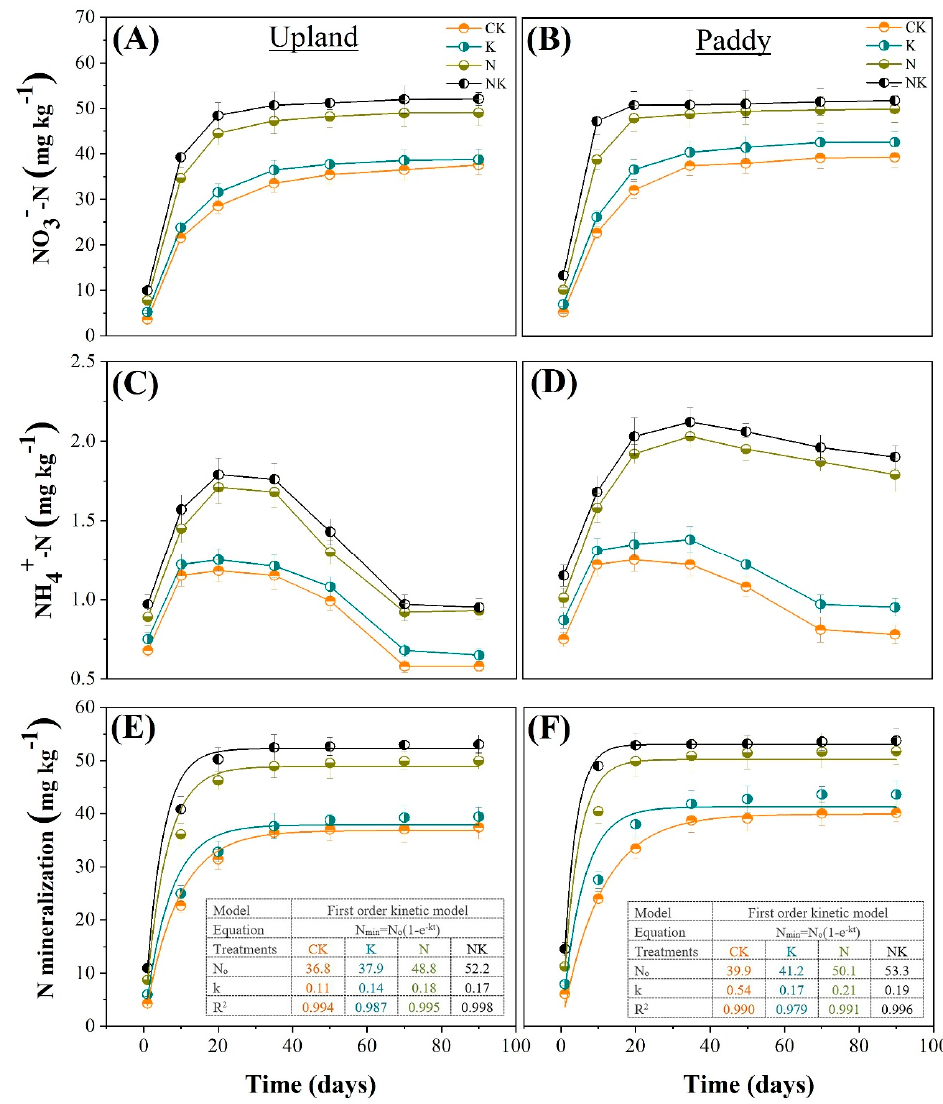
Figure 3. The concentrations of NO 3 − -N, NH 4+ -N and net N mineralization in different fertilization management practices after 90 days of incubation in upland ( A , C , E ) and paddy soils ( B , D , F). The error bars denote the least significant difference values at the 0.05 level using the least significance difference (LSD) test.